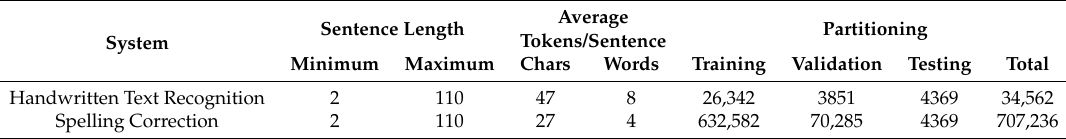
Table 6. Data distribution from All in One database.